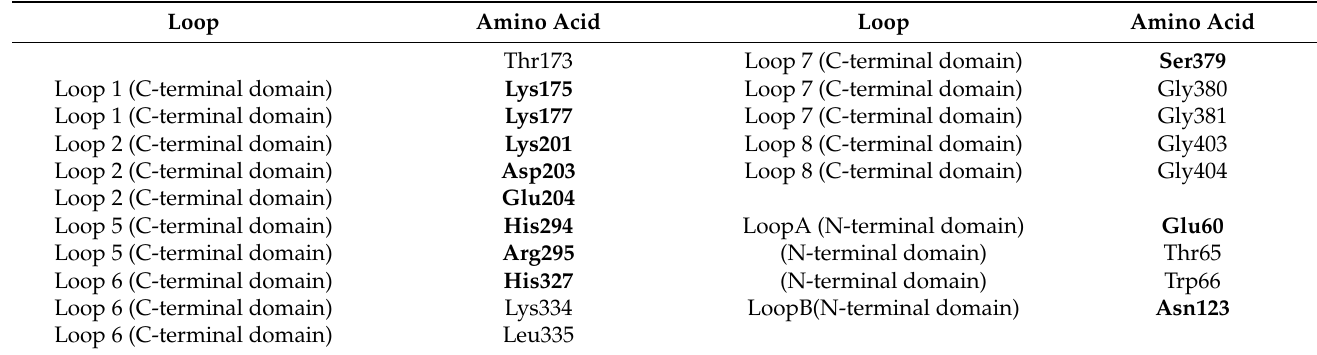
Table 1. A distance <4.0 Å between amino acid residues and 2CABP was used to identify amino acids which were catalytically competent. The list denotes amino acids located at the C-terminal end of the αβ -barrel of L1 subunit and at the N-terminal end of the antiparallel L2 subunit. Amino acid residues represented in bold are strongly conserved among Rubisco proteins (Table from ref. [36], used by permission of Elsevier (copyright ©